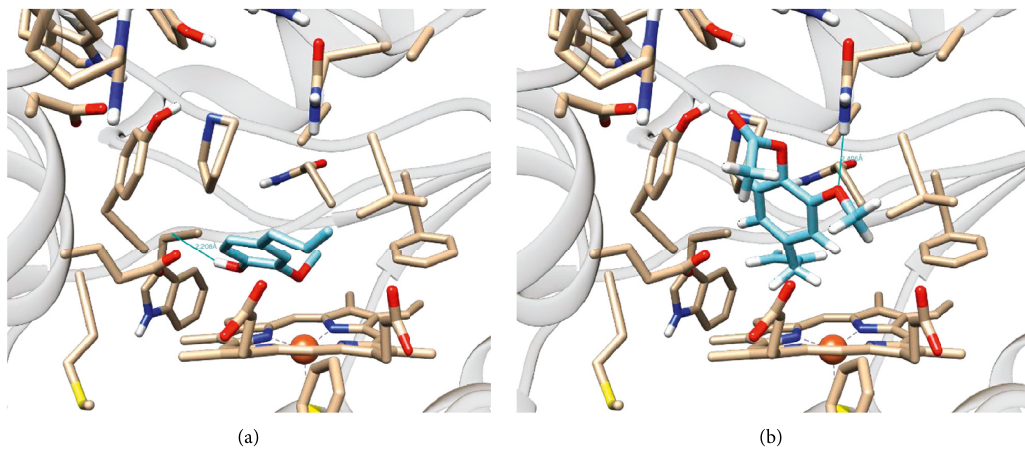
Figure 3: Docking pose eugenol (a) and (b) eugenol acetate on the active site of the NO synthase